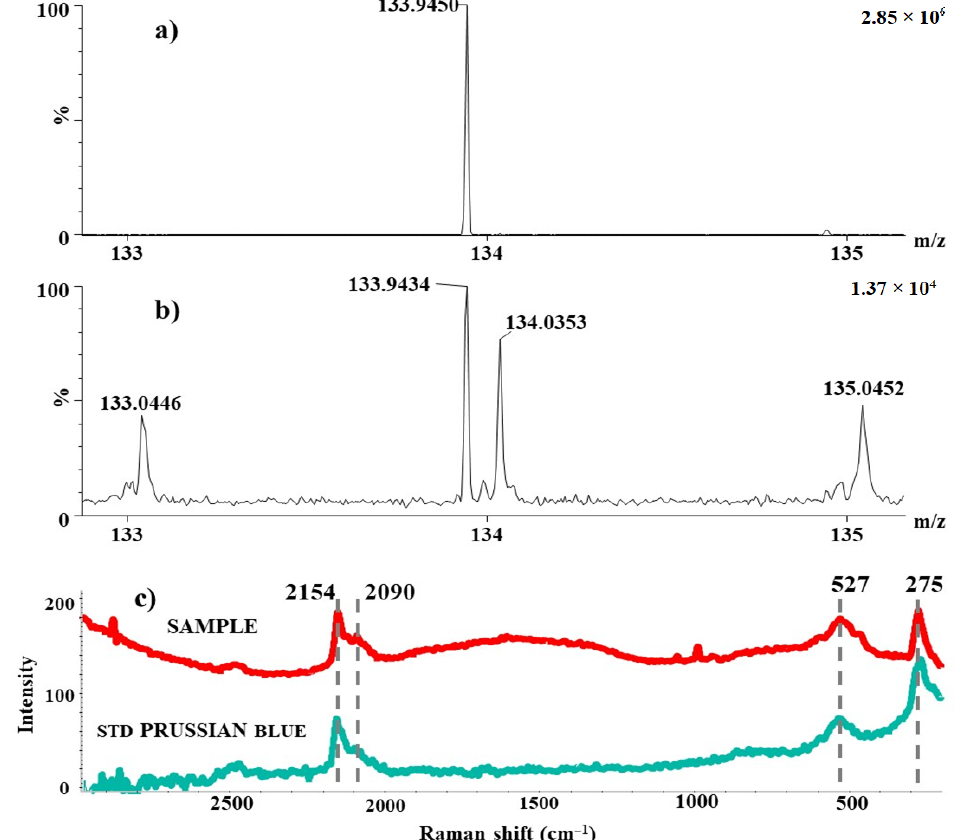
Figure 4. MS spectrum of the PB standard ( a ), MS spectrum of analysis of the blue powder ( b ), Raman spectrum of the blue powder, and the PB standard ( c ). Analysis of the organic binders in blue powder was performed by ASAP-IM-MS and LDI-MS. The content of organic additives was substantially lower in this sample com- pared to the sample of the pink powder. In the blue powder, we identified only the same diglycerols as in the case of the pink powder, SS, SP, and PP with dtm 1.2, 1.2, and 1.3 mDa, respectively (for fragmentation spectra see Figures S11–S13). The LDI-MS in the negative ionisation mode detected three common fatty acids, i.e., palmitic, stearic, and oleic acid in the blue faience powder, further confirming the presence of fatty material in the faience materials (see Figures S14 and S15). We hypothesise that the blue mixture also